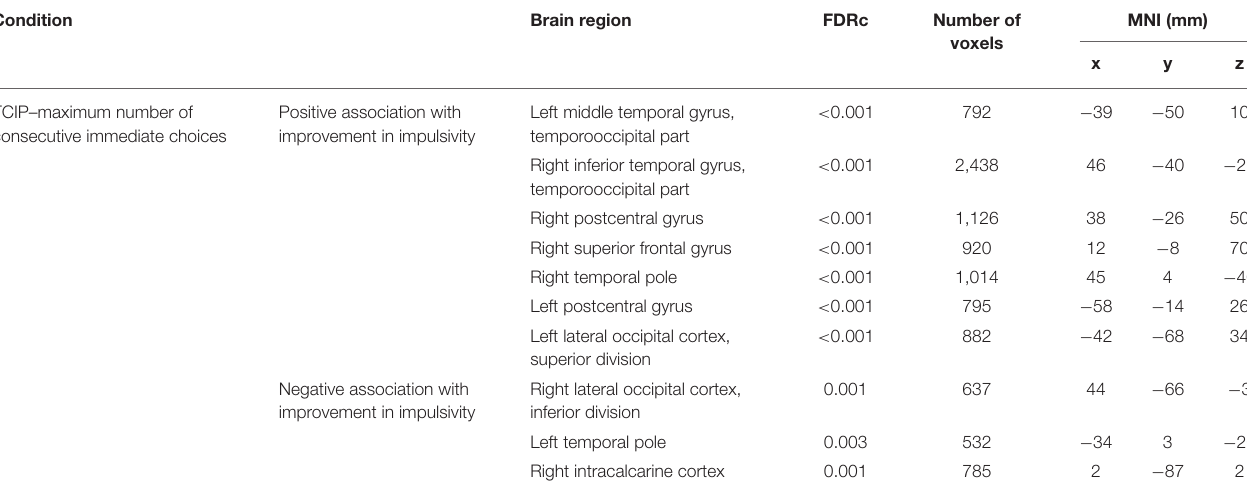
TABLE 4 | Positive and negative associations between gray matter volume and positive impulsivity change score.